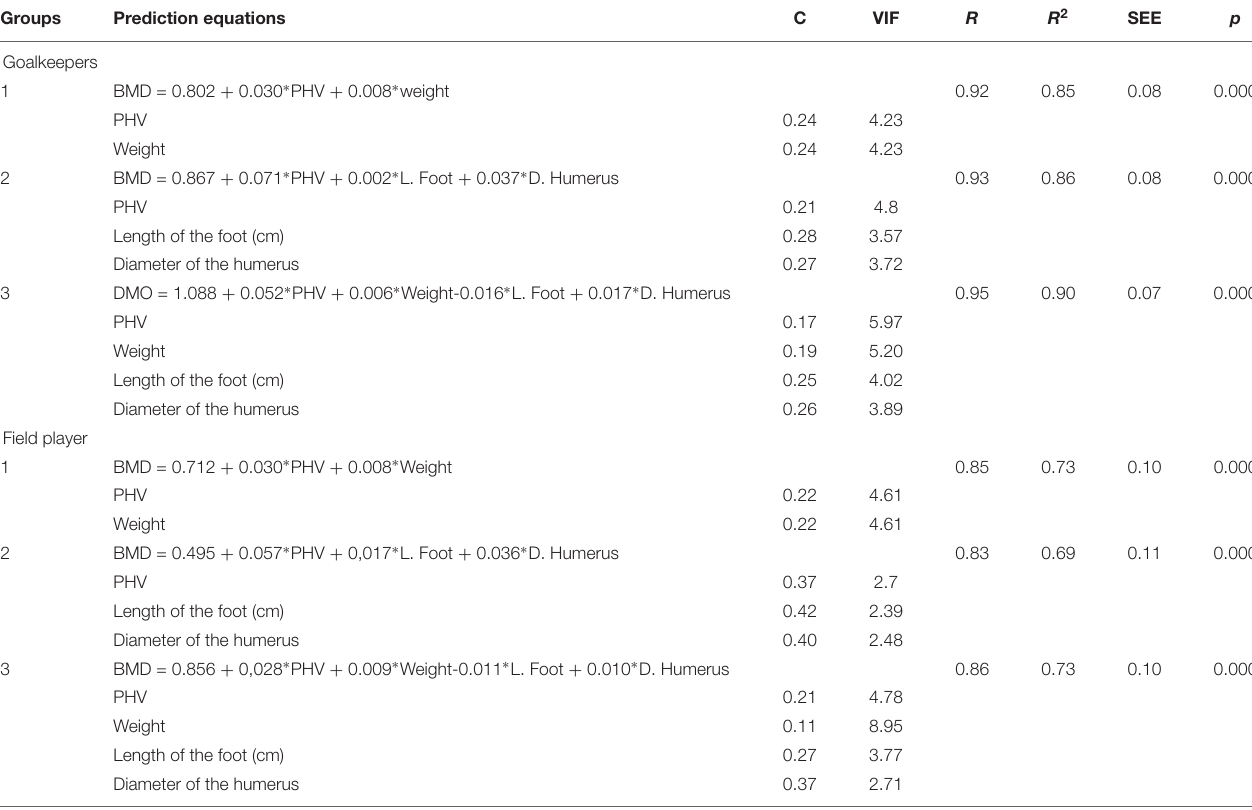
TABLE 4 | Regression equations to predict the BMD of goalkeepers and field players. Groups Prediction equations C VIF R R 2 SEE